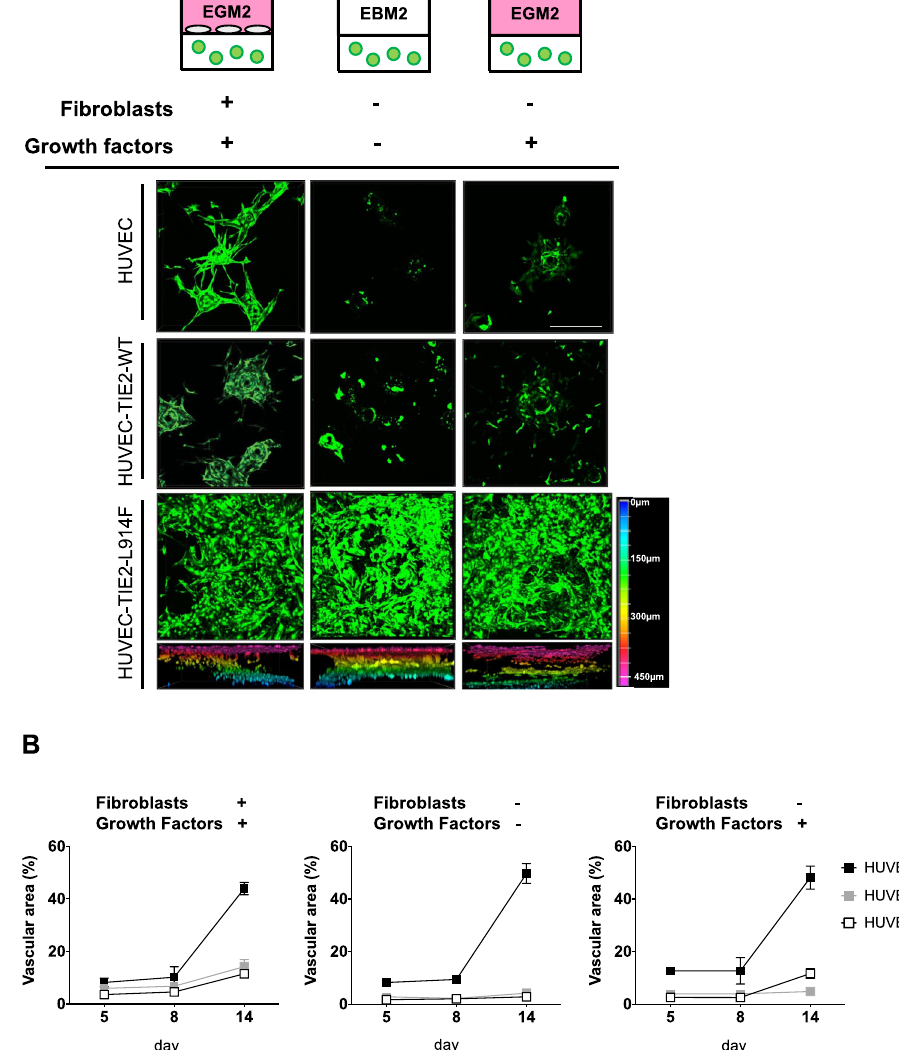
Figure 3. HUVEC-TIE2-L914F form enlarged vascular channels even in the absence of fibroblasts and growth factors. (A ) Schematic of the experimental conditions utilized (top panel). Z-stack images (max projection) at day 14 of HUVEC, HUVEC-TIE2-WT and HUVEC-TIE2-L914F in the fibrin gel without fibroblasts and/or full growth factor medium (EGM2: endothelial growth factor medium; EBM2: endothelial basal medium). Scale bar: 200 μ M. Color-coded diagram of depth images of HUVEC-TIE2-L914F fibrin gel is represented (bottom panel). ( B) Quantification of vascular area in HUVEC, HUVEC-TIE2-WT and HUVEC-TIE2-L914F fibrin gels with and without fibroblasts and/or full growth factor medium at different time points. (n = 3 independent vascular